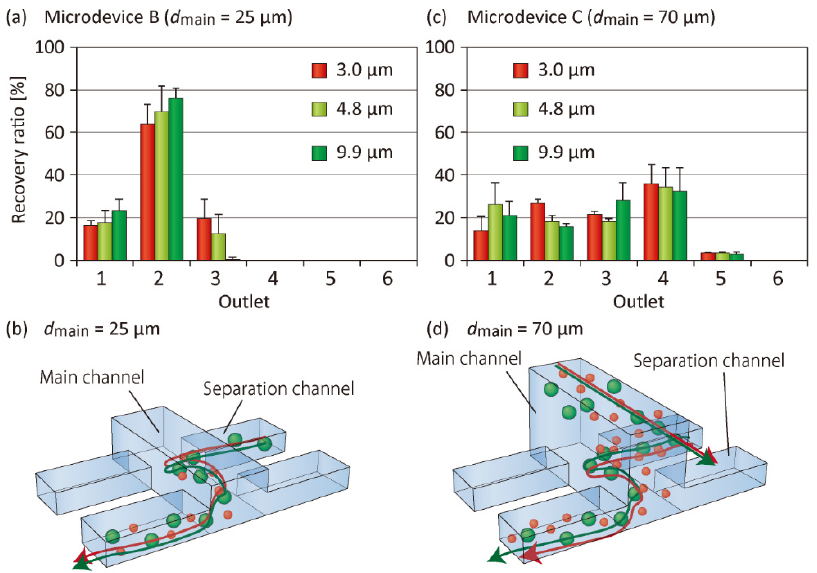
Figure 6. Recovery ratios of three types of microparticles and schematic images showing the particle behaviors in the dual-depth lattice channels. ( a , b ) Microdevice B with the main channel depth of 25 µ m and ( c , d ) Microdevice C with the main channel depth of 70 µ m. In ( a , c ), each set of data represents the mean ± SD from three individual experiments.